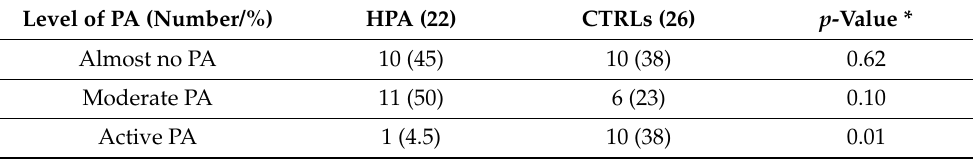
Table 3. Level of Physical activity (PA) in patients and